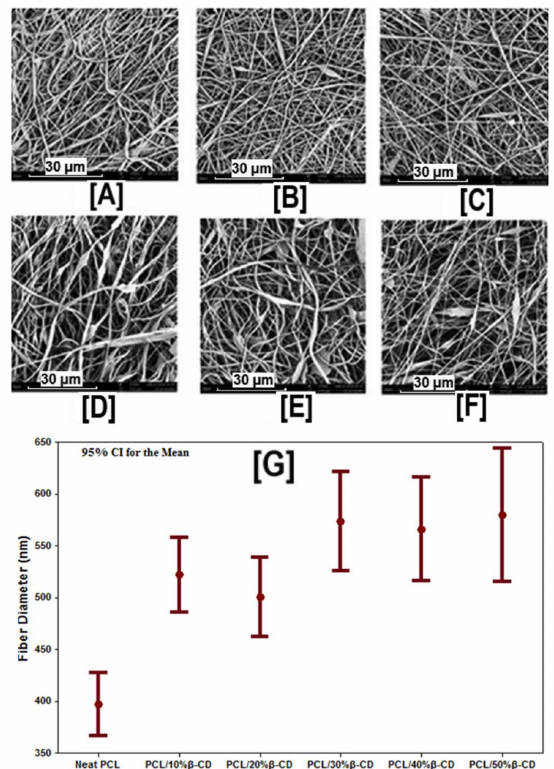
Figure 5. SEM images and average fiber diameters of β -CD functionalized PCL nanofibers at various β -CD loadings (0% to 50%). SEM images indicate the absence of beaded structures in PCL and PCL/ β -CD nanofibers. While a marginal increase in fiber size was observed with the addition of β -CD (520 ± 200 nm for 10% β -CD vs. 400 ± 160 nm for neat PCL), further increases in β -CD concentration did not lead to further increases in fiber diameter. Images adapted and reproduced with permission from [43]. Copyright John Wiley and Sons